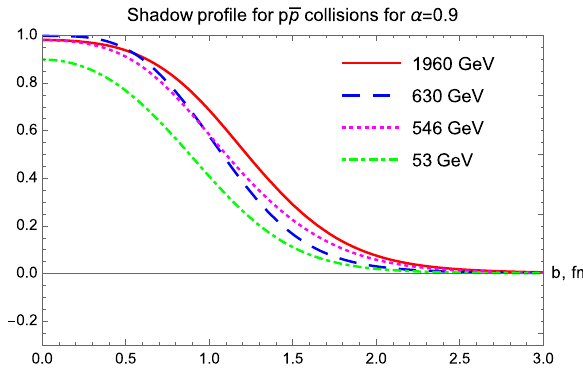
√ s = 13 and 7 √ s = 1 . 96 TeV